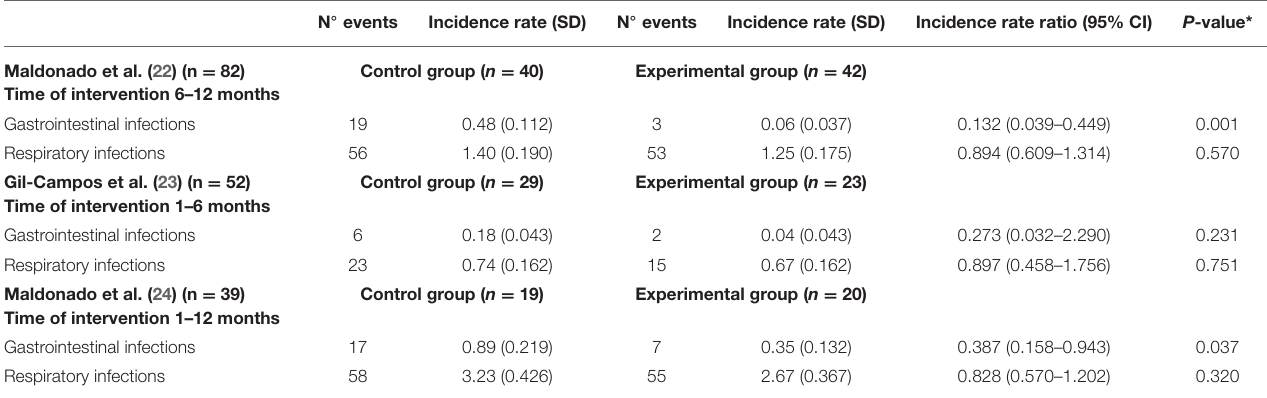
TABLE 2 | Incidence of gastrointestinal and respiratory infections in infant born by